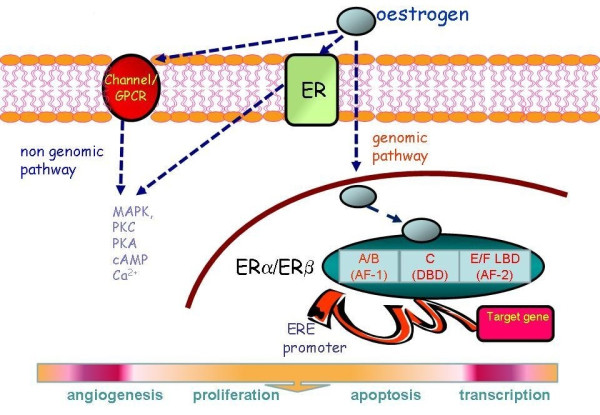
Pathways of oestrogen action. The ERα/ERβ is a simplified schematic of the ER. MAPK mitogen activated protein kinase, PKC protein kinase C, PKA protein kinase A, cAMP 3'-5' cyclic adenosine monophosphate, Ca2+ intracellular calcium, DBD DNA binding domain, LBD ligand binding domain.